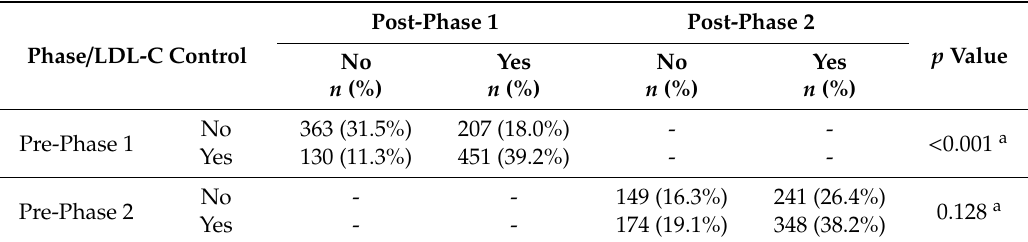
Table 2. Changes in low-density lipoprotein cholesterol (LDL-C) control after the development of Phases 1 and 2 of the CPG